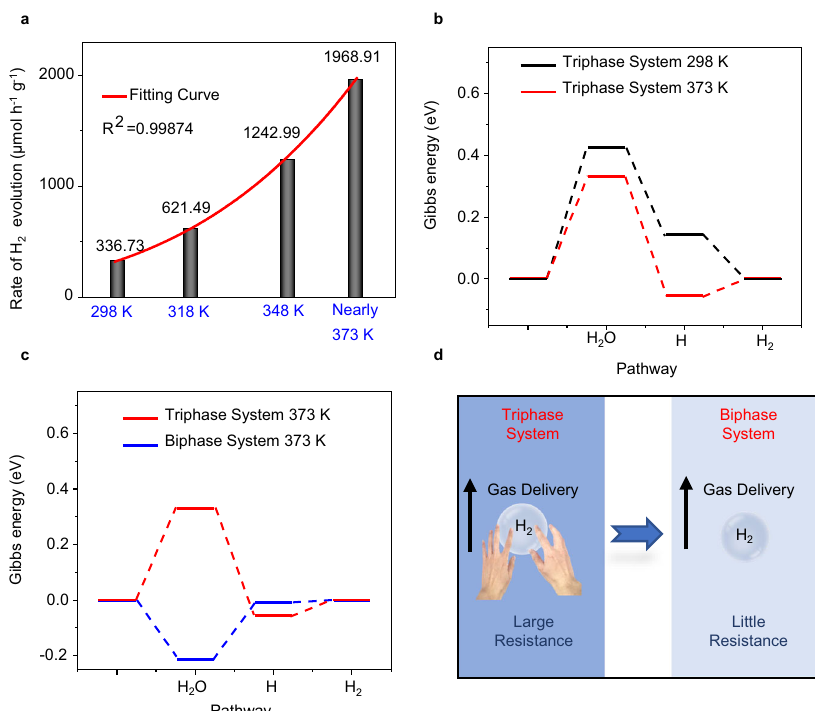
Fig. 4 The factors governing the biphase photocatalytic hydrogen evolution: temperature and liquid-to-gas-phase changes of water. a The photocatalytic hydrogen evolution rate with the CoO NPs versus the reaction temperature in the triphase reaction system. (Here, the background pressure was maintained at 5 kPa). b Gibbs energy of a photocatalytic reaction in the triphase system with different temperatures over the pure CoO surface. The photocatalyst is CoO NPs. c Gibbs energy of a photocatalytic reaction in the triphase system (373 K) in comparison with the biphase system (373 K) over the pure CoO surface. The photocatalyst is CoO NPs. d Schematic of the hydrogen transport resistances in the liquid- and gas-phase